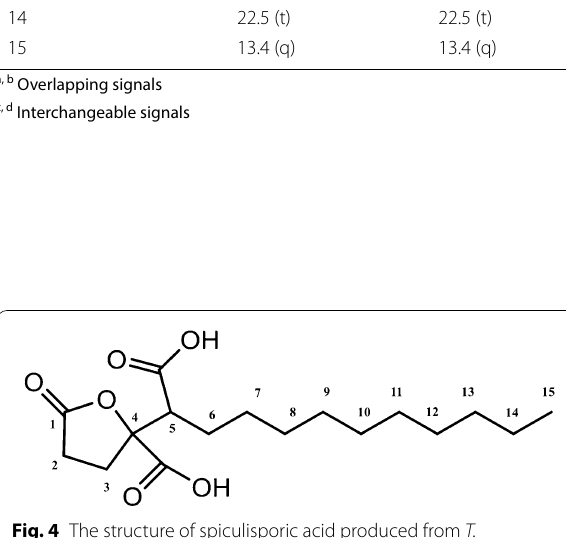
Fig. 6 Effect of carbon sources on spiculisporic acid production by T. trachyspermus NBRC 32238. The initial substrate concentration was 100 g/L. Cultivation was carried out at 28 °C for 7 days. Error bars indicate standard deviations from three independent